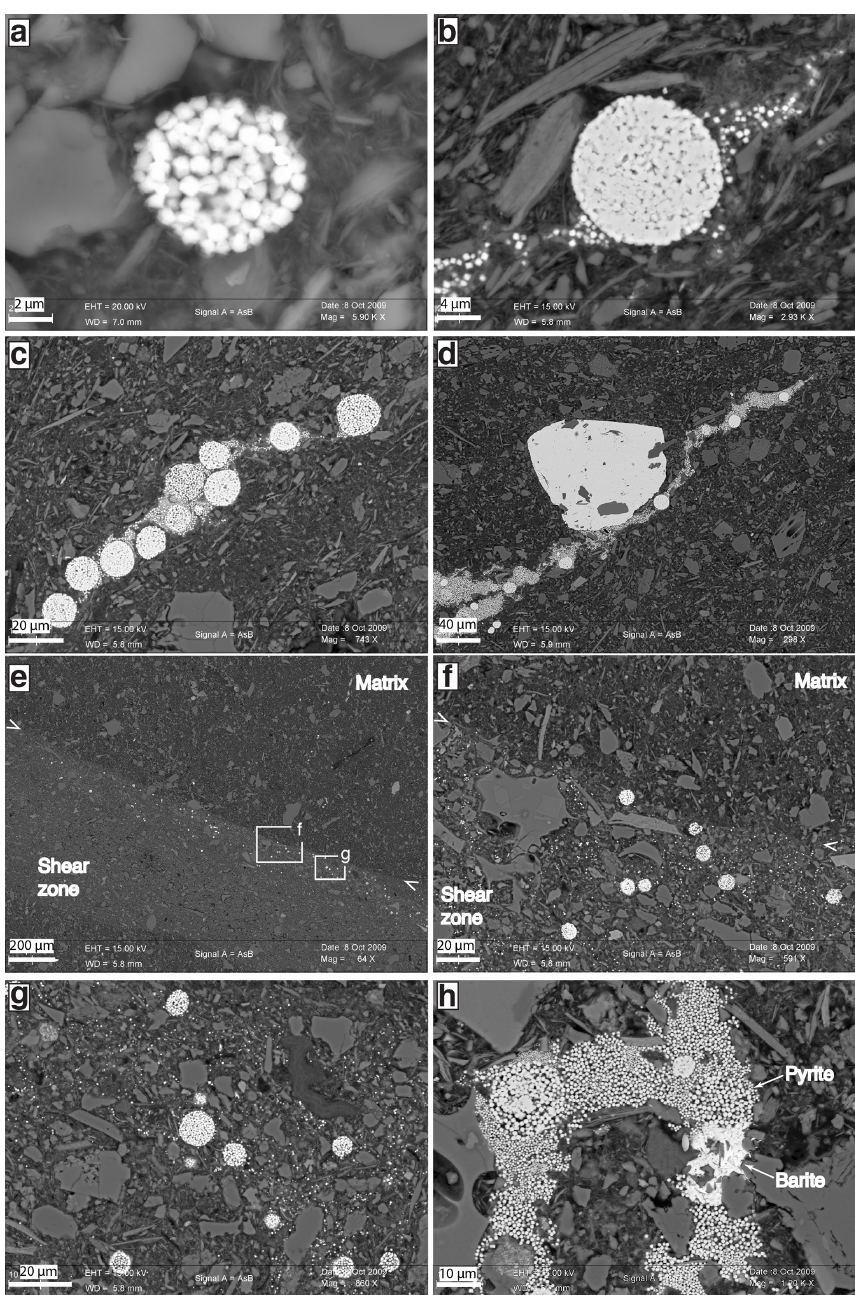
Figure 3. SEM pictures of pyrite textures. (a) Pyrite framboid made of aggregated cubic pyrite microcrysts in a shear zone (sample 21R-2, 82- 85). (b) Pyrite framboid in a shear zone, with pressure shadow-like tails of isolated microcrysts (4R-3, 73-76), showing that the microcryst morphology grew before and/or during deformation. (c) Same as (b) with a lower magnification. (d) Blocky euhedral pyrite macrocryst embedding particles oriented parallel to the crystallographic preferred orientation (CPO) in a shear zone, showing that blocky pyrite growth is posterior to the CPO (4R-3, 73-76). (e, f, g) Pyrite framboids and isolated cubic pyrite microcrysts in a shear zone (21R-4, 89-93). Arrows delimit the boundary between the shear zone (with a CPO of particles) and the matrix (with randomly oriented particles). Note the greater abundance of pyrite crystals in the shear zone compared to the matrix. (h) Barite flakes surrounded by pyrite microcrysts and framboids in a vein. A wider view of the structure is provided in Fig. 5 (21R-2, 82-85).